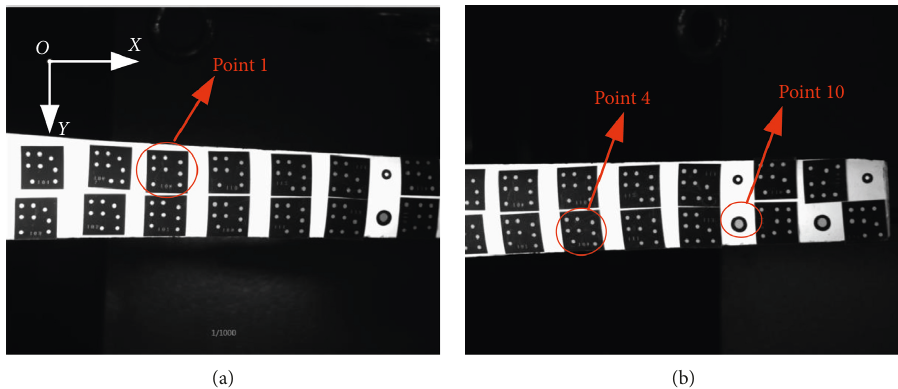
Figure 3: Blade images taken by using the cameras: (a) left camera and (b) right camera.